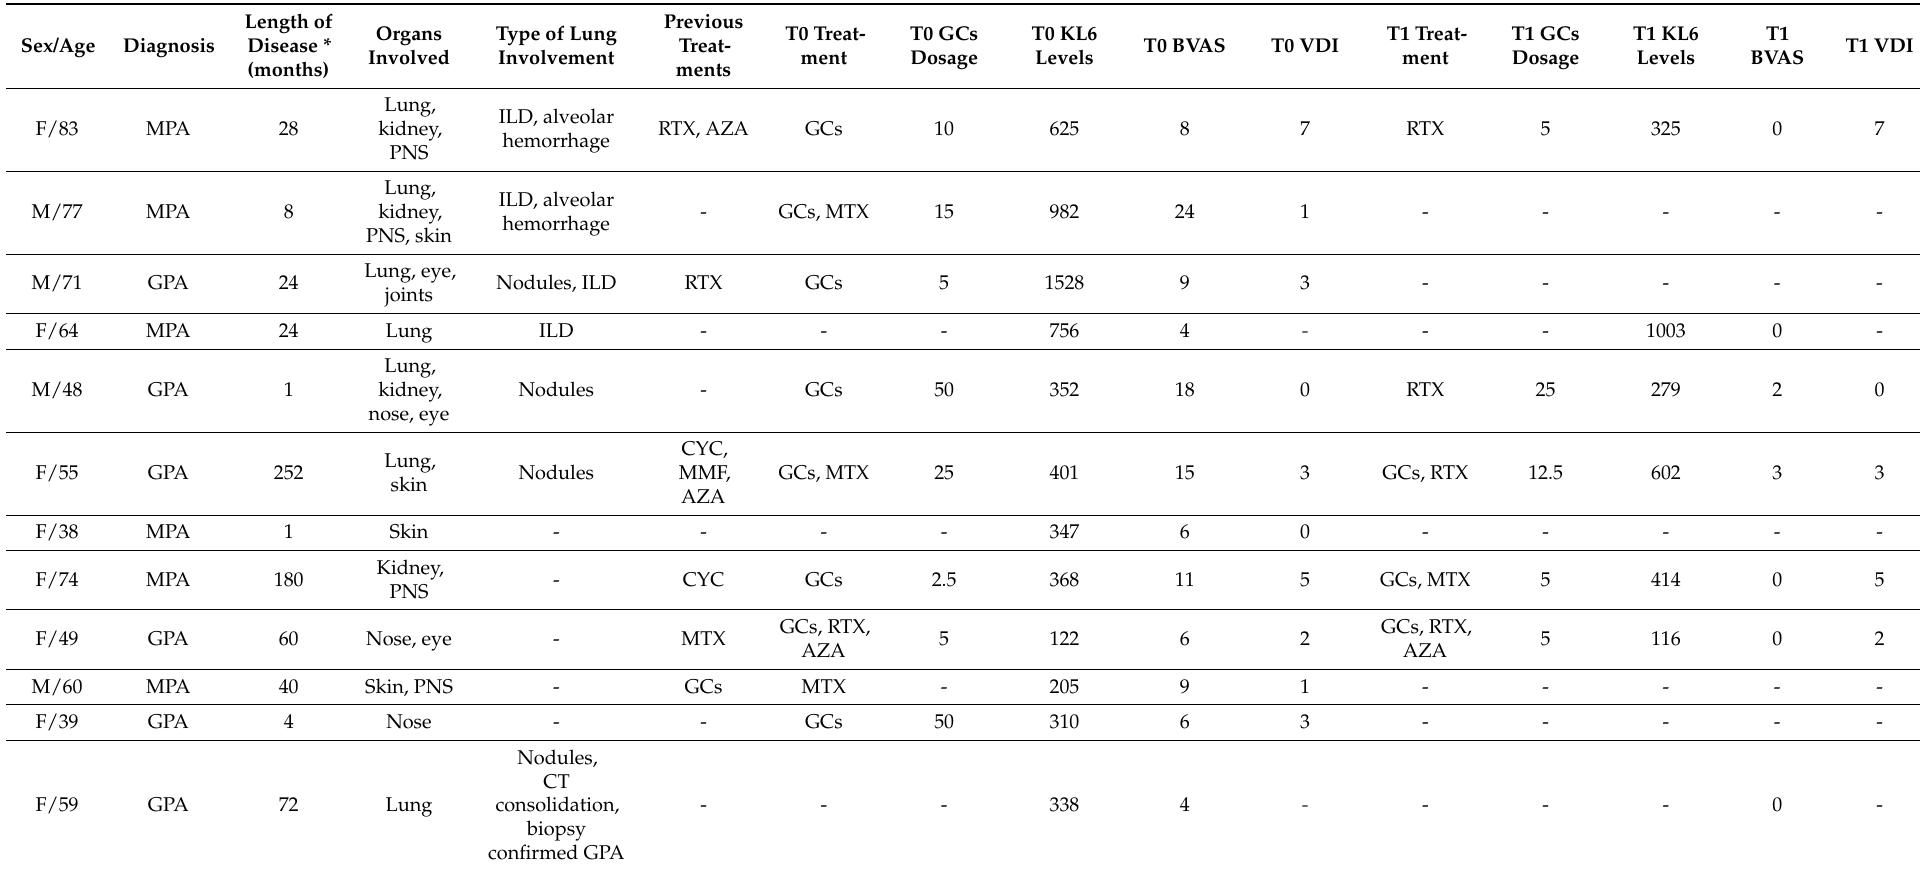
Table 1. Clinical, immunological, and demographic data of AAV patients. Abbreviations: AZA: azathioprine; BVAS: Birmingham vasculitis activity scale; F: female; GCs: glucocorticoids; GPA: granulomatosis with polyangiitis; KL6: Krebs von den Lungen; M: male; MMF: mycophenolate mofetil; MPA: microscopic